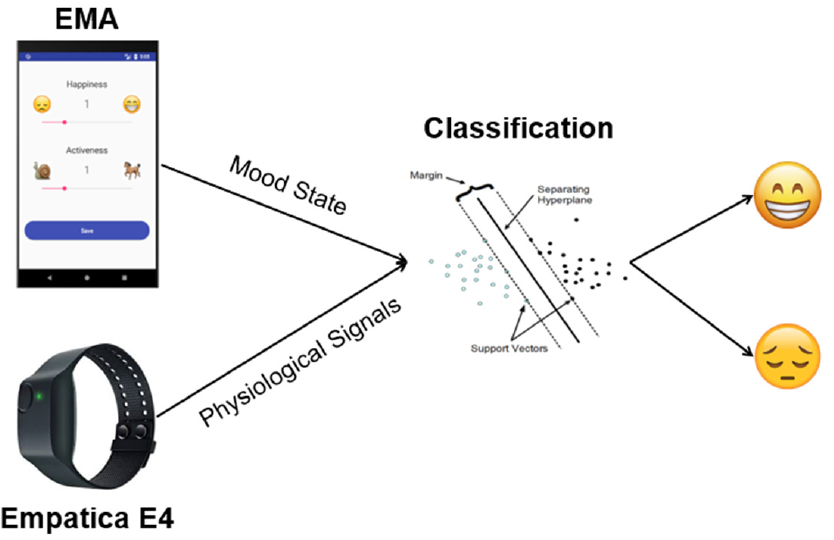
Figure 3. Machine-learning classification method of training the mood estimation algorithm [15]. Table 1. Information collected by the Android.